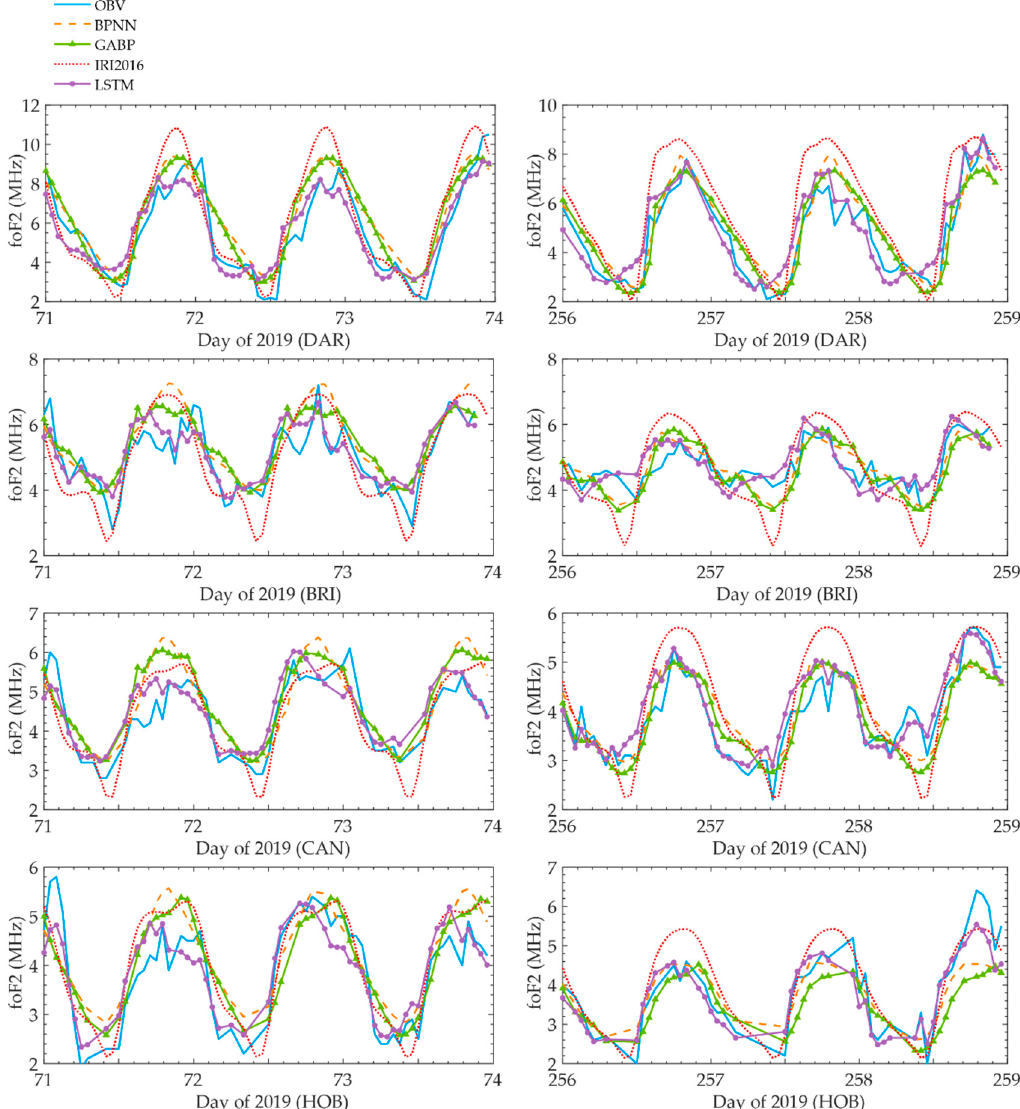
Figure 6. Samples of comparisons of daily variations for observed (blue solid line) and 4 models forecasting foF2 values during a quiet period in the year of solar minimum (2019) during days 71–74 and 256–259.